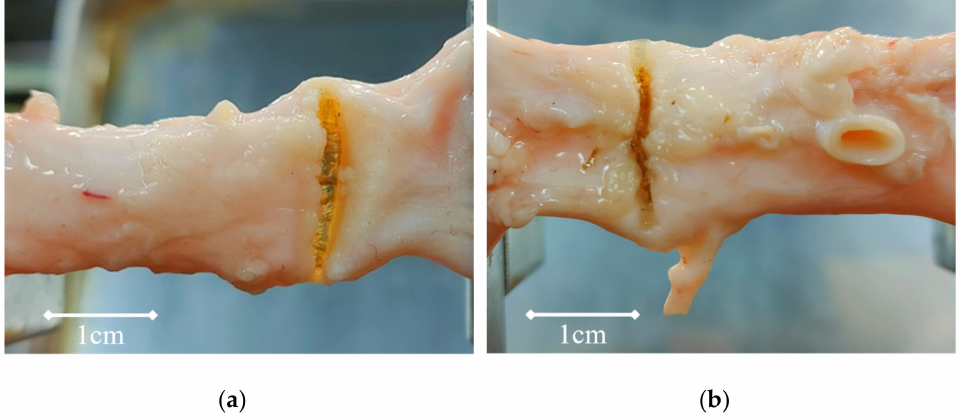
Figure 4. ( a ): When the welding time is 30 s, the welding area becomes glass-like tissue, the thickness decreases and the light transmittance increases. ( b ): When the welding time is 20 s, the welding area changes from pink to translucent white, and the reddish-brown floc is the thermal denaturation product of